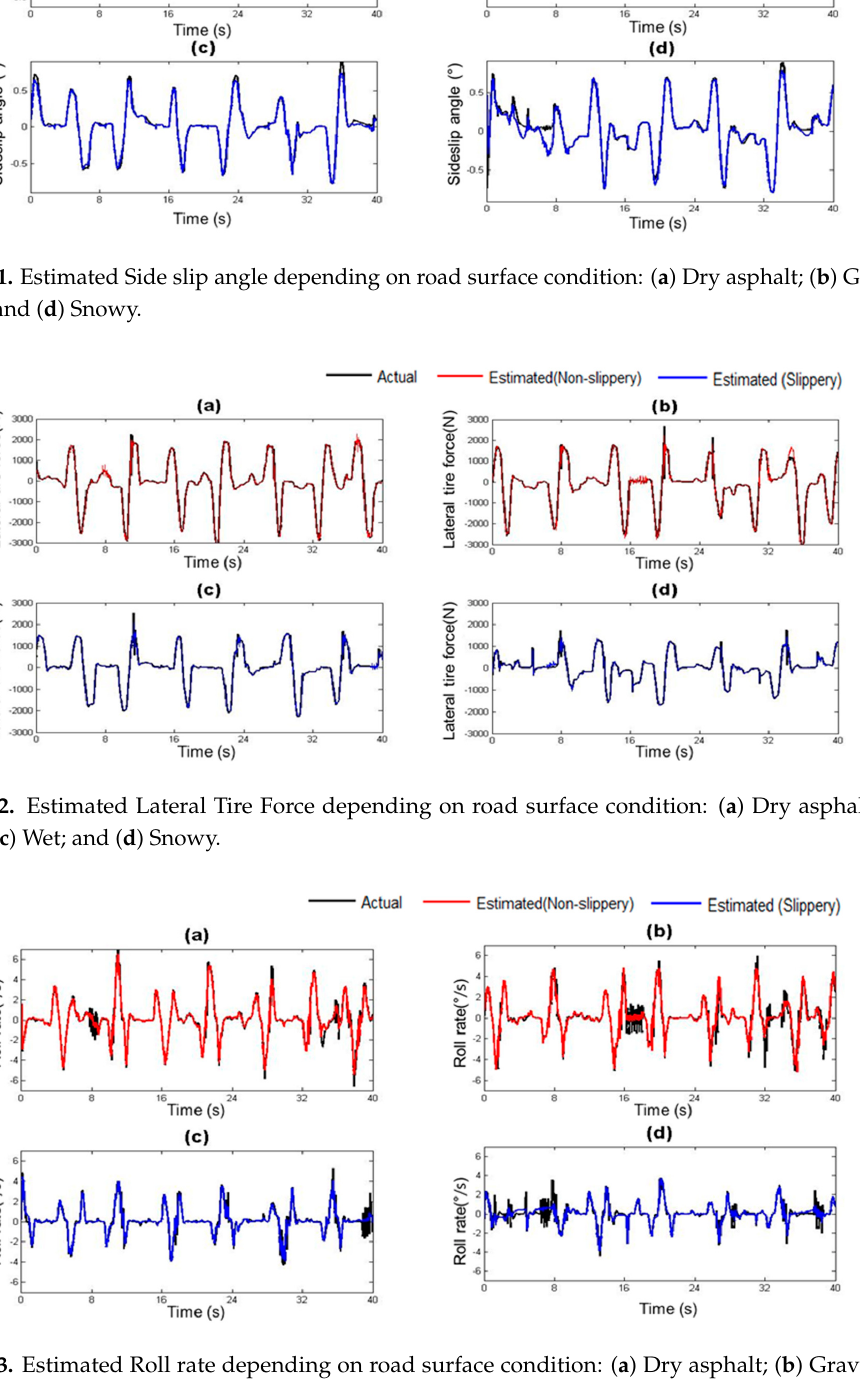
Figure 13. Estimated Roll rate depending on road surface condition: ( a ) Dry asphalt; ( b ) Gravel; ( c ) Wet; and ( d )